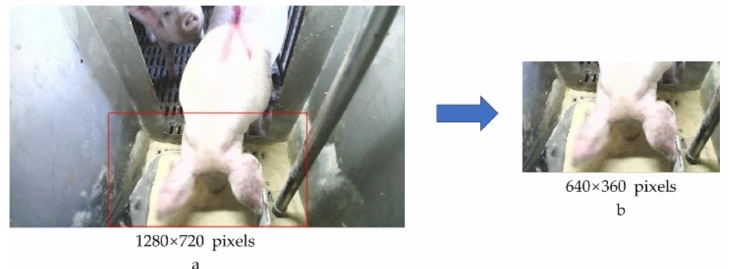
Figure 4. Image caught by FARS and image cutting. Raw image ( a ); image after cutting ( b